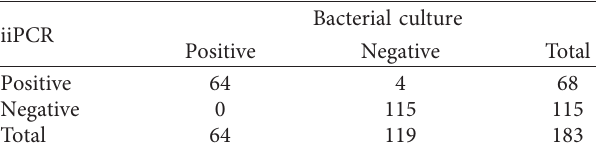
Table 2: Clinical evaluation of the iiPCR